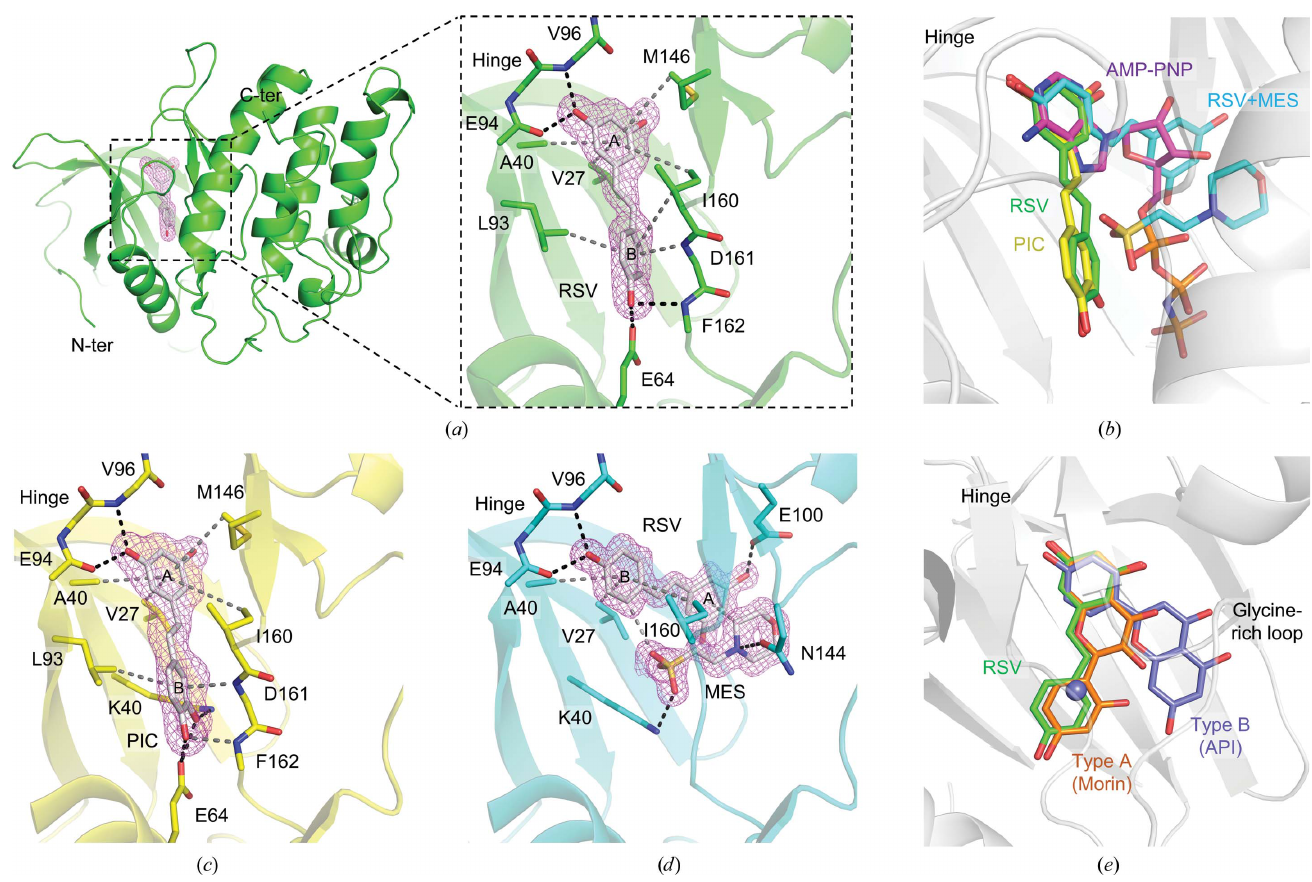
Figure 4 ( a ) Overall structure of DAPK1 in complex with RSVand close-up view of the binding of RSV to the ATP-binding site (PDB entry 7ccu). The magenta mesh indicates the polder map (Liebschner et al. , 2017) for RSV contoured at 3.3 (cid:3) . The black and gray dashed lines indicate hydrogen bonds and CH (cid:4)(cid:4)(cid:4) (cid:4) interactions, respectively. ( b ) Comparison of the binding modes of AMP-PNP (PDB entry 1jkk), RES (PDB entry 7ccu), PIC (PDB entry 7ccv) and RES+MES (PDB entry 7ccw). The C atoms of AMP-PNP, RSV, PIC and RSV+MES are colored purple, green, yellow and cyan, respectively. ( b ) The binding mode of PIC (PDB entry 7ccv). The polder map was contoured at 3.3 (cid:3) and is shown as a magenta mesh. ( d ) Simultaneous binding of RES and MES (PDB entry 7ccw). The polder map was contoured at 3.3 (cid:3) and is shown as a magenta mesh. ( e ) Comparison of the binding modes of RSV (PDB entry 7ccu), API (PDB entry 5auv) and morin (PDB entry 5auy) in their DAPK1 complexes. The C atoms of RSV, API and morin are colored green, slate blue and orange,